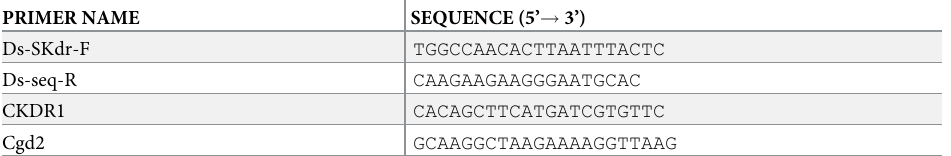
Table 3. Primers used to amplify and sequence the trans-membrane segments 4 to 6 of the domain II region of the voltage-gated sodium channel of Drosophila suzukii